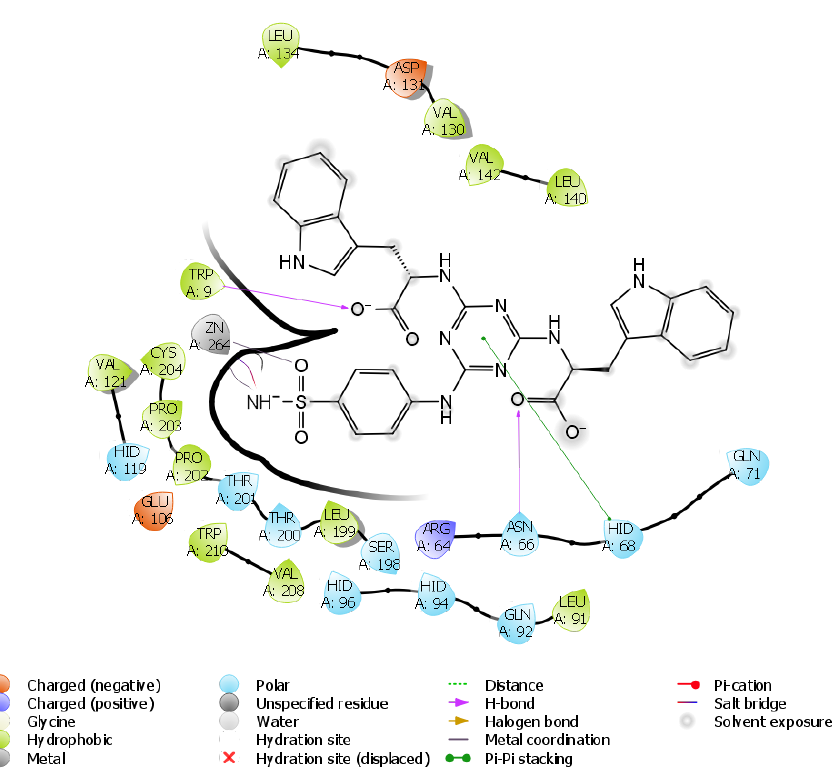
Figure 4. Intermolecular interactions of compound 6 (Trp derivative) docked into hCA IX.